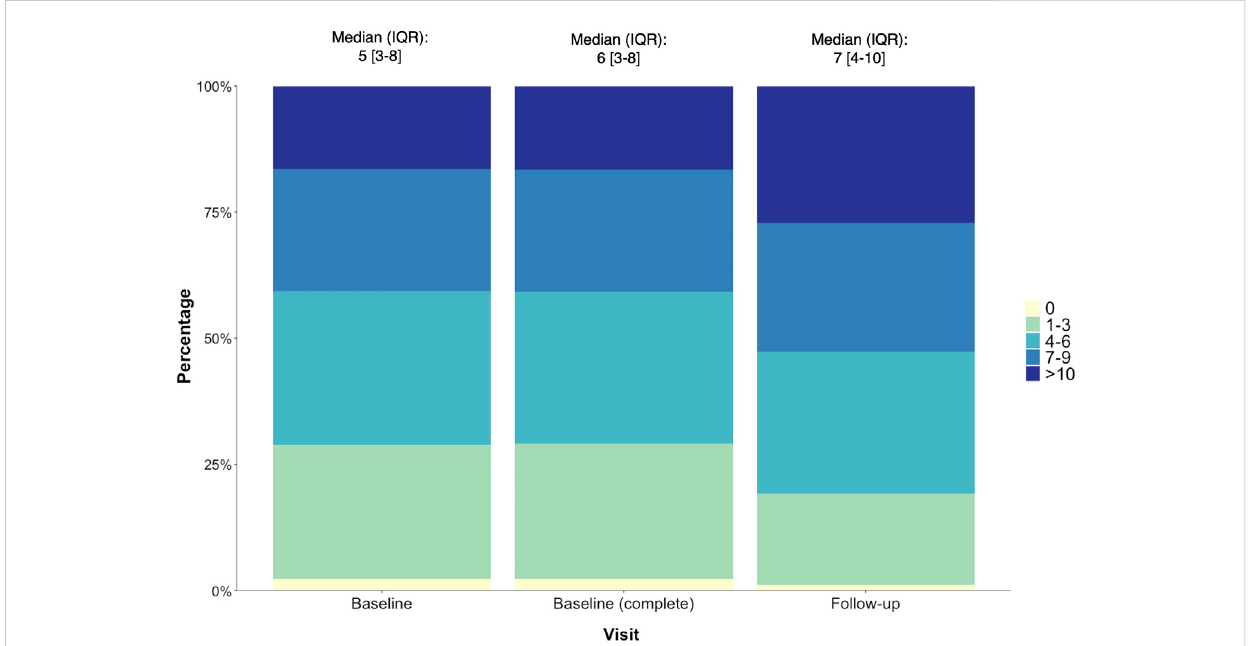
FIGURE 1 The number (%) of comorbidities reported by POPPY participants with HIV at baseline ( n = 1,073), baseline (returned for follow-up, n = 788) and follow-up ( n = 788), with the median (IQR) number of comorbidities per individual also reported.